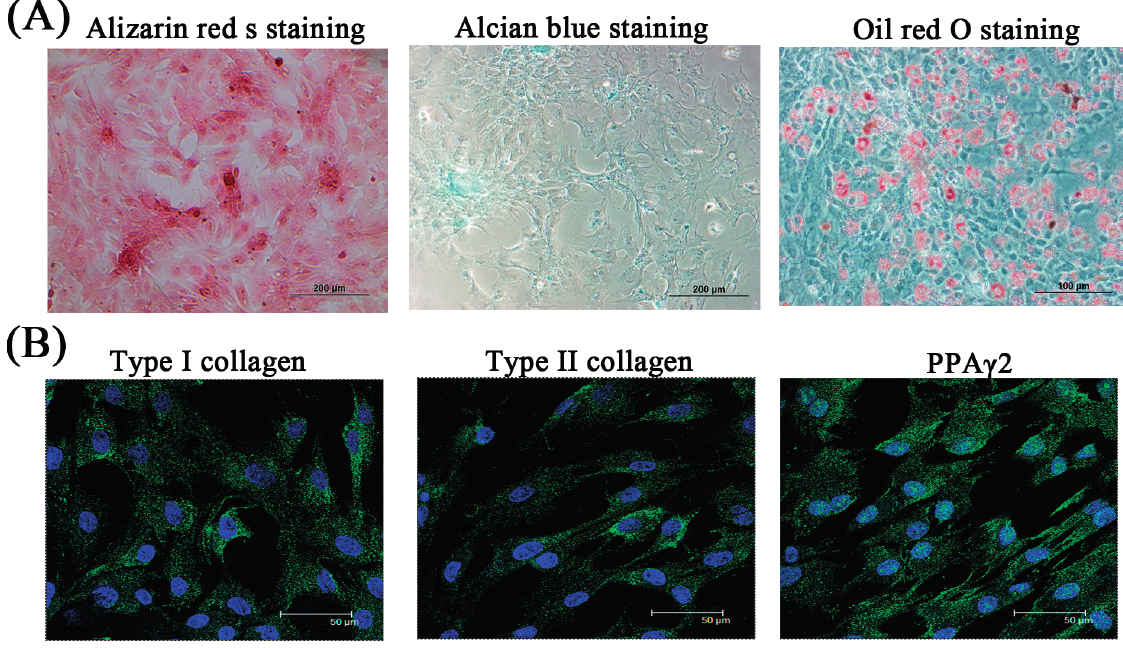
Figure 4. Evaluation of differentiation potential of SF-MSCs by histological staining and immunofluorescence staining. Histological staining ( A ) and immunofluorescence staining ( B ) of SF-MSCs after osteogenic (Alizarin red S stain and Type I collagen), chondrogenic (Alcain blue stain and Type II collagen), and adipogenic (Oil red O stain and PPA γ 2) induction. Green: extracellular matrix and blue: cell